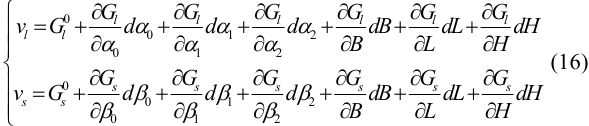
the plane distance is calculated from the image coordinates of the ground control point. Then, the original RPC error image plane accuracy distribution of the image space can be